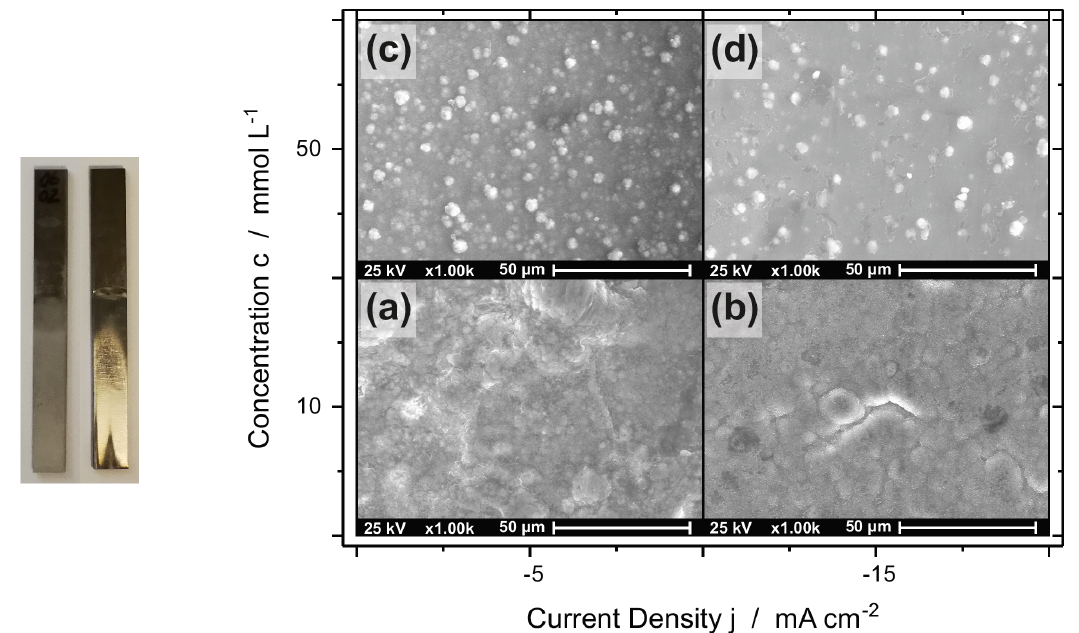
Figure 1. Photographs of AlCr coatings on steel with increasing Cr content (left to right: 3 wt% and 10 wt%) and SEM images of AlCr alloys of ca. 10 µm thickness on steel substrate, deposited at −5 mA cm −2 ( a , c ) and −15 mA cm −2 ( b , d ) from [EMIm]Al 2 Cl 7 –10Cr (a,b) and [EMIm]Al 2 Cl 7 –50Cr ( c , d ).